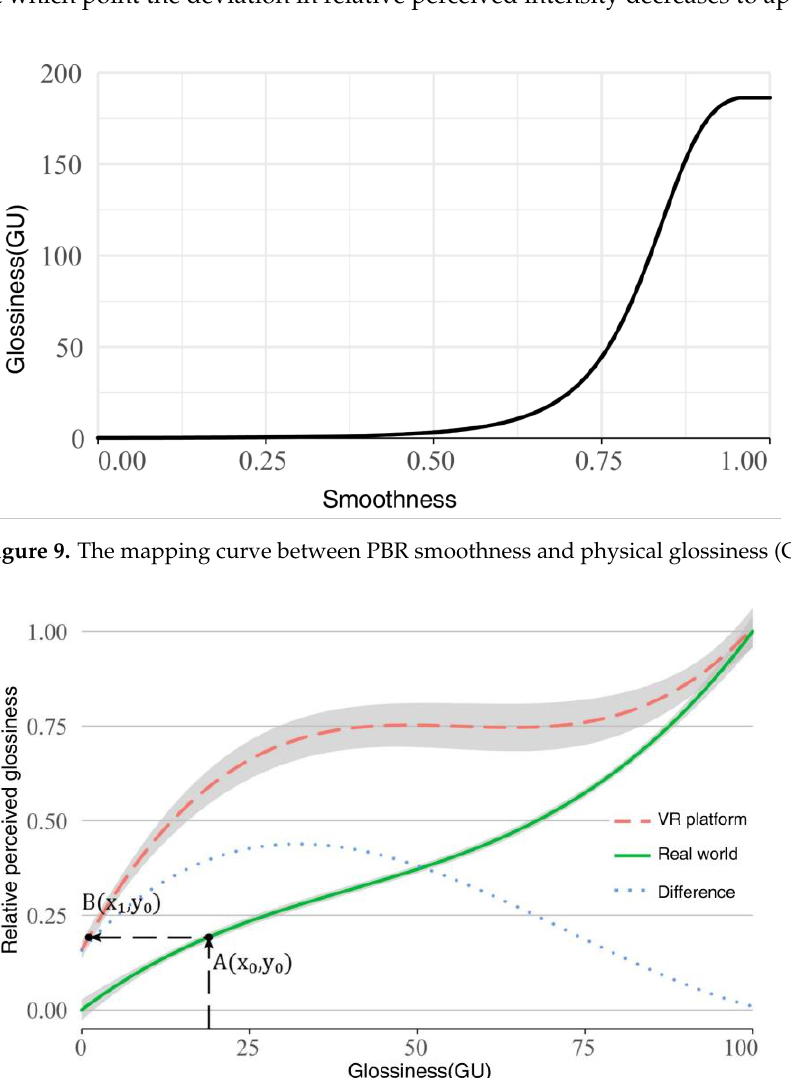
Figure 9. The mapping curve between PBR smoothness and physical glossiness (GU).